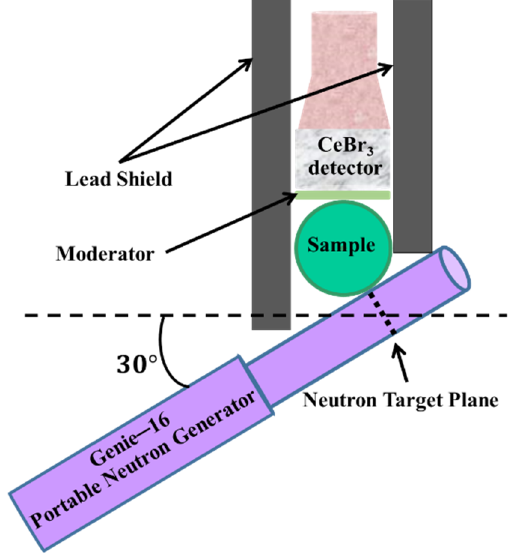
Figure 2. Schematic representation of the PGNAA setup used for neutron inelastic scattering reaction built around Genie 16. Figure is not drawn to scale. Table 1. Optimizations of Genie 16 setup in order to obtain the best net counts for a pure Ti sample.